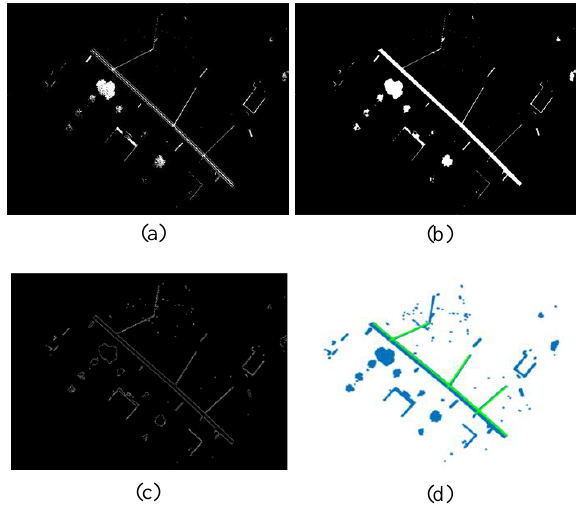
Figure 10. Cable area detection using the HT algorithm. (a) Creating a binary image from the remaining point cloud after low-height objects filtering; (b) Applying closing morphological operator to enhance the binary image; (c) Edge detection by canny algorithm; (d) Detected lines with the HT algorithm that are transferred back to the point cloud space.